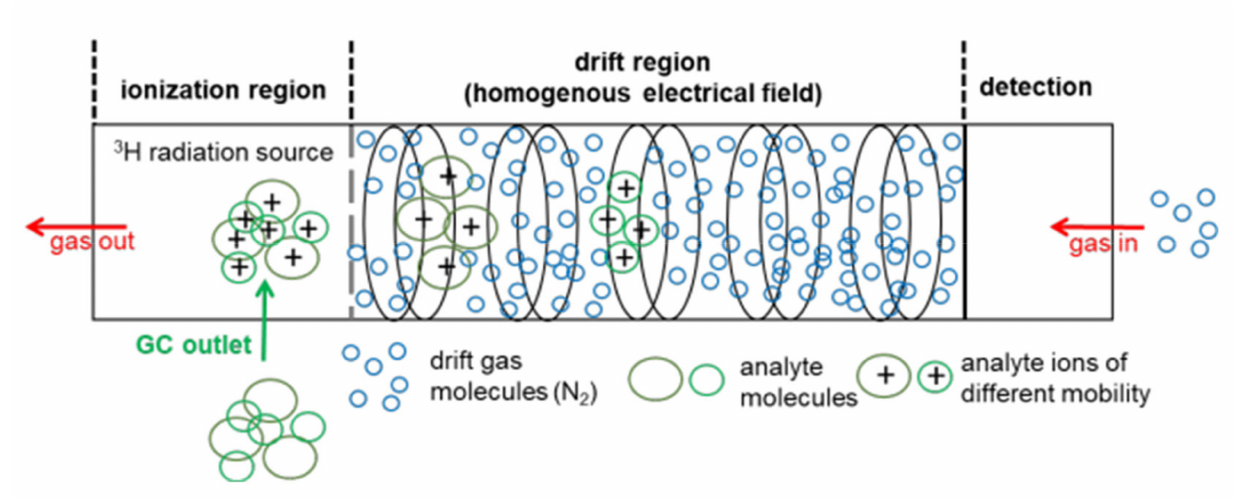
Figure 1. Setup of a drift-time IMS with a tritium (H-3) ionization source, adopted from [38] with permission